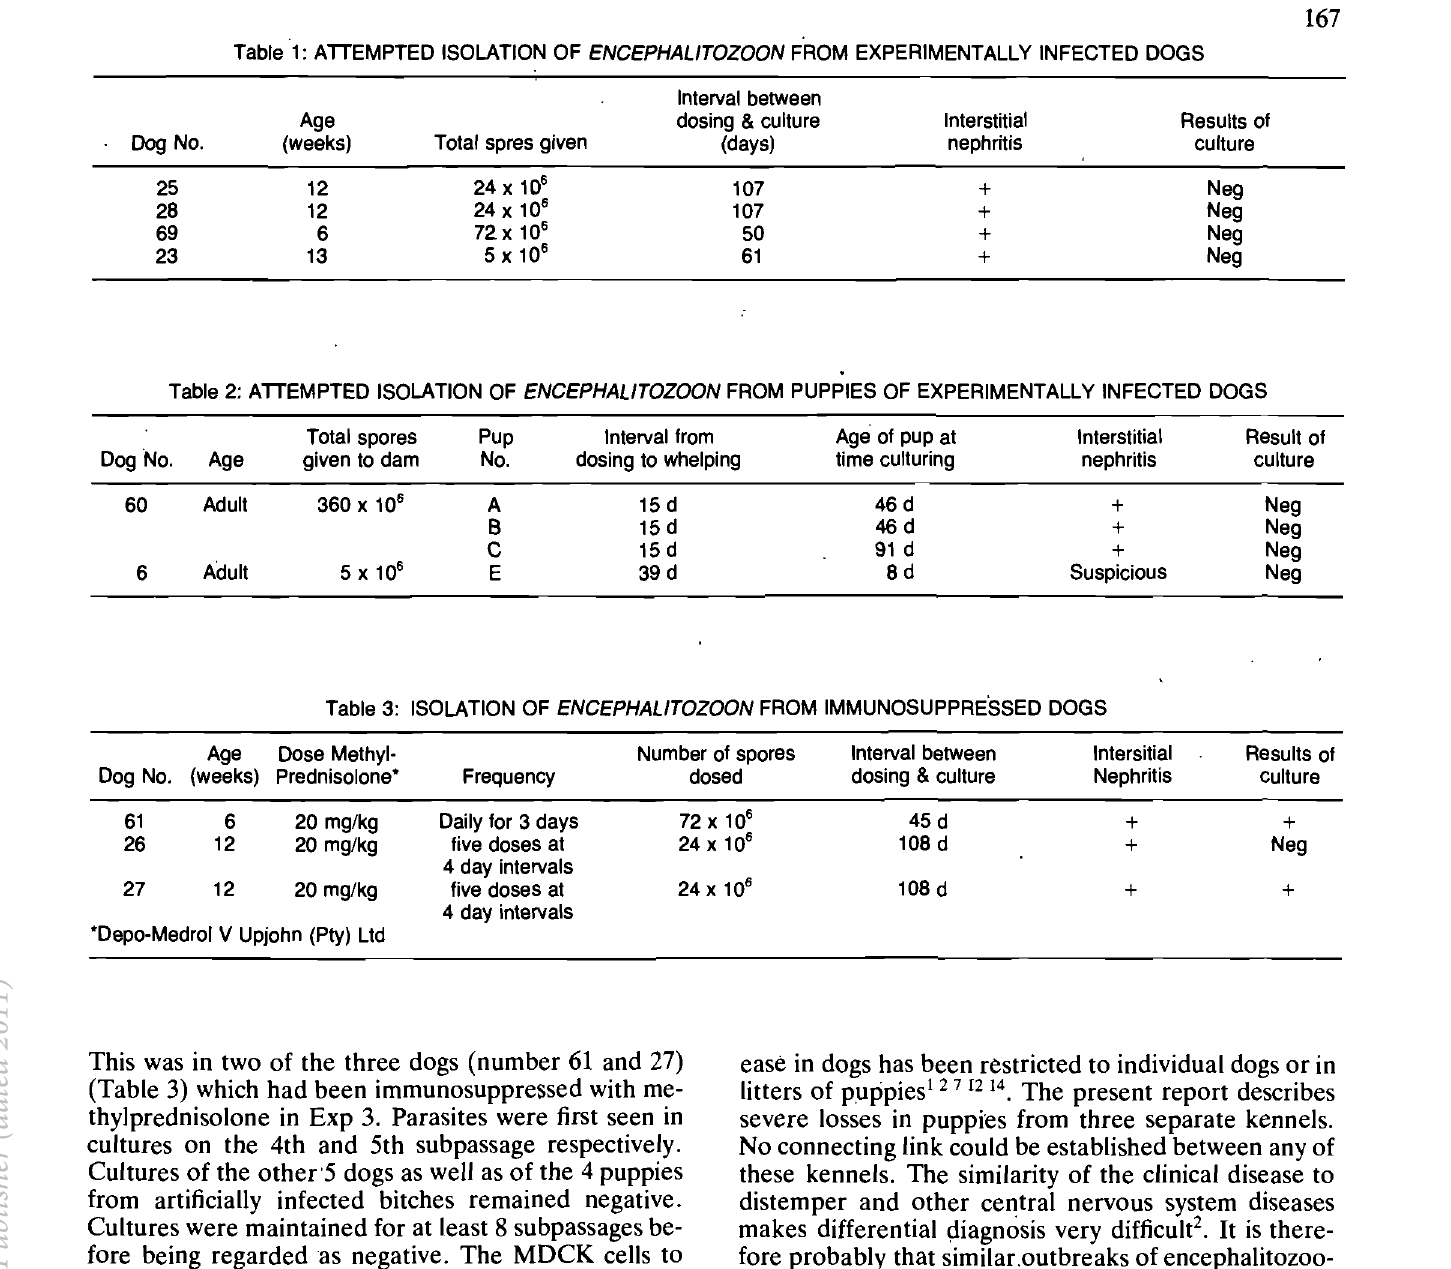
Table 1: ATTEMPTED ISOLATION OF ENCEPHALITOZOON F'ROM EXPERIMENTALLY INFECTED DOGS